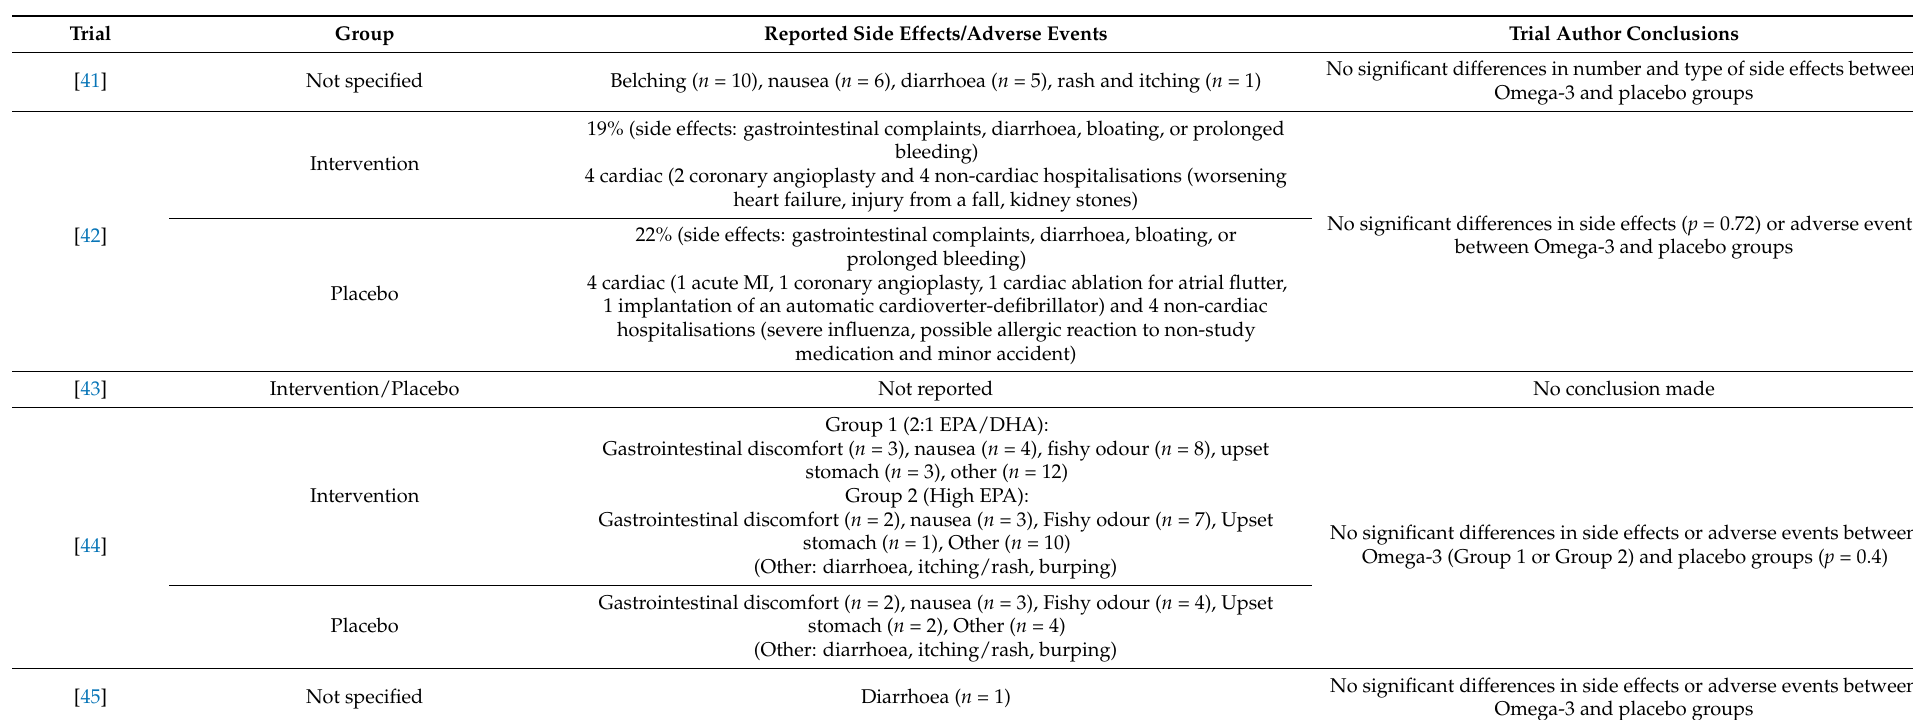
Table 2. Side effects and adverse events profile of included